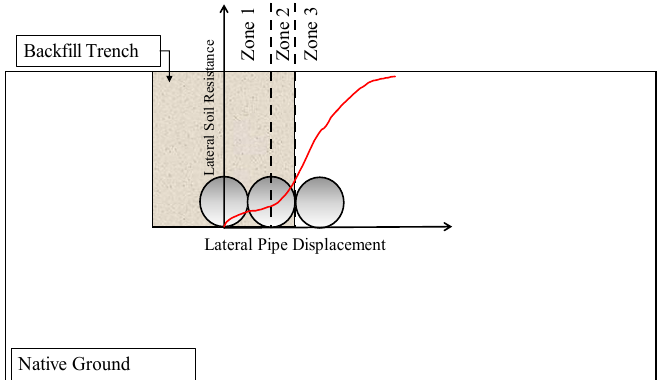
Figure 4. The lateral response of trenched and backfill pipeline to ground displacement.